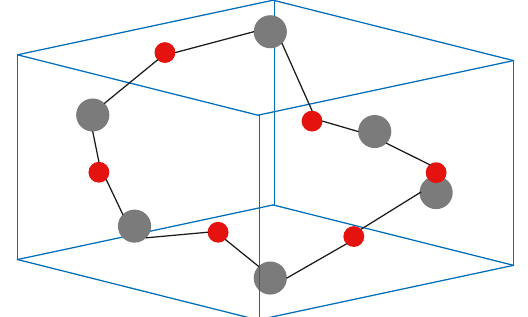
Figure 1: Quartz crystal